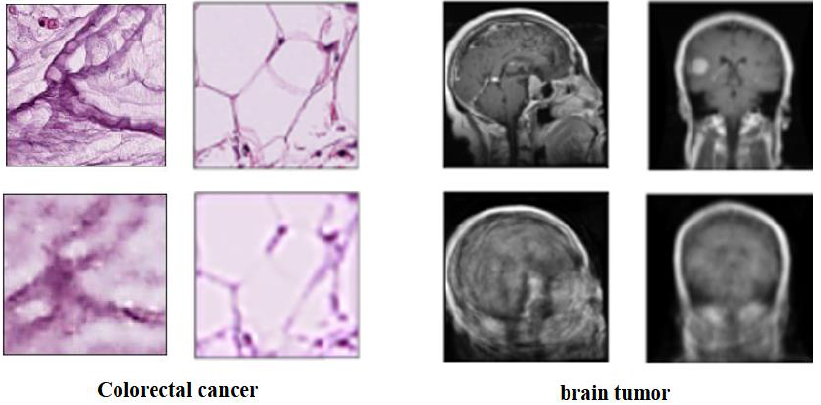
Figure 4. The SAE for unlabelled images; first row: the original images of the dataset, second row: the reconstructed images.